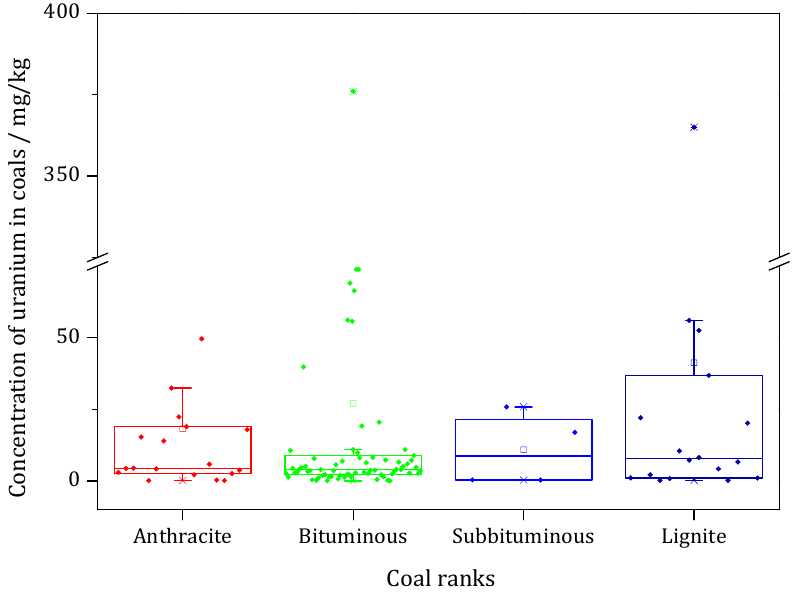
Figure 5. Variation of uranium concentrations in Chinese coals of different ranks.